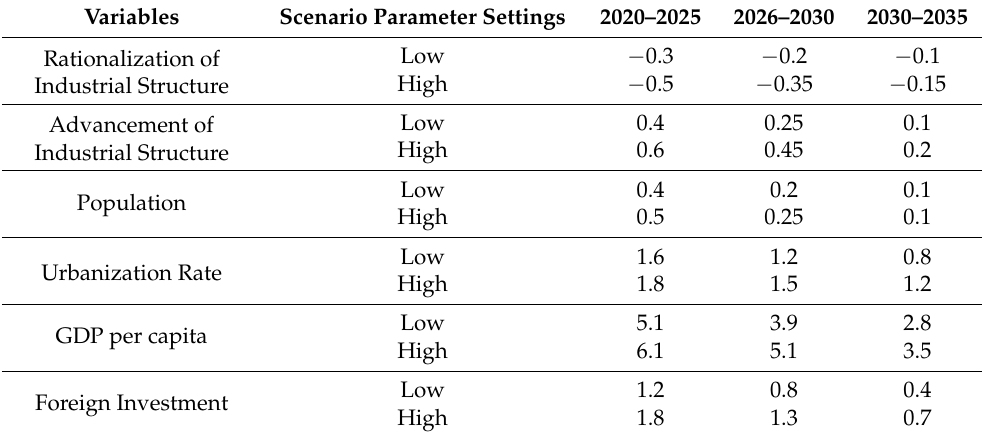
Table 6. Parameter settings under different scenarios.